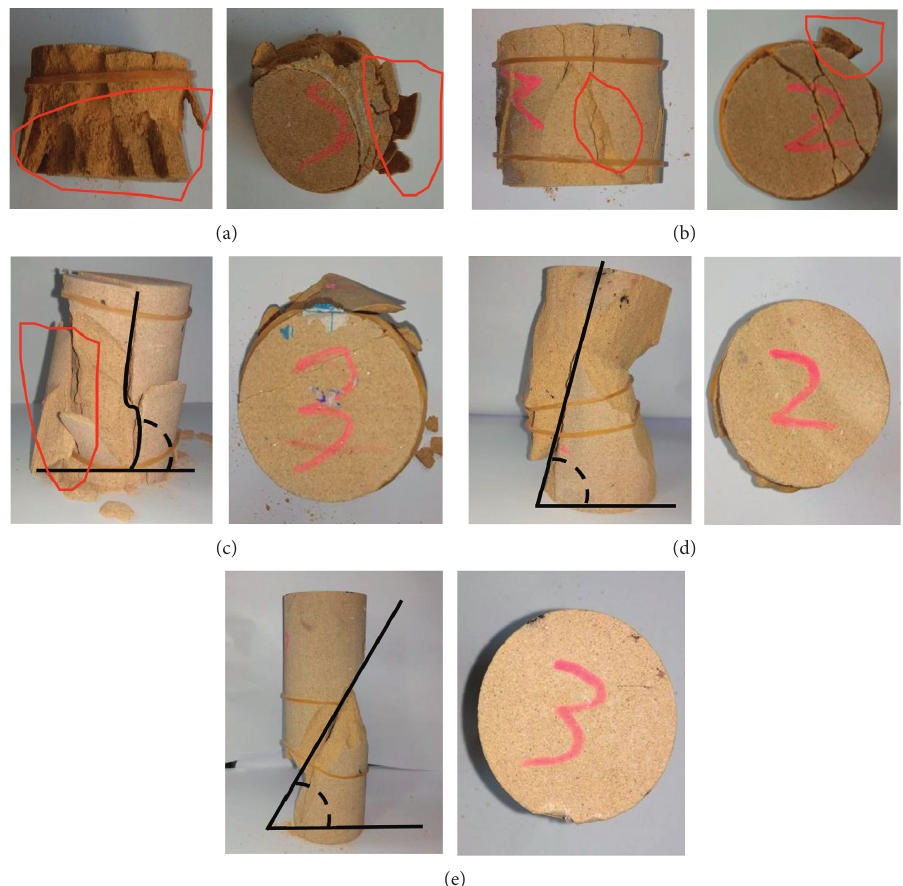
Figure 6: The failure characteristics versus the slenderness ratio (the red regions represent the location of fall-blocks, the angles made up of two black lines represent the angle between those two failed zones and horizontal axis). (a) D � 0.5. (b) D � 1.0. (c) D � 1.5. (d) D � 2.0. (e) D �